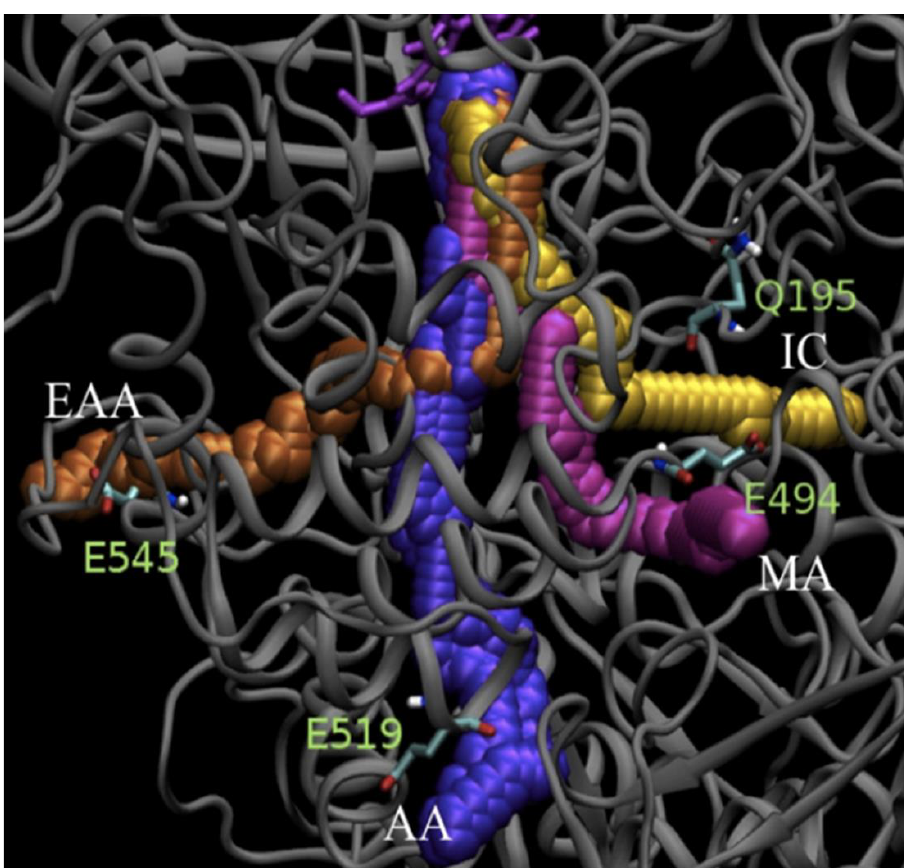
Figure 5. Permeability of accesses and channels in CAT-1. Access to the gate and the active site was determined with the CAVER program. The starting point was at the Fe of the heme. Traces define the main access and channel (MA) (pink), the auxiliary access (AA) (purple), the interconnecting channel (IC) (yellow) and the entrance to the auxiliary access (EAA) (orange). All these traces converge at the gate. Accesses are identified by the following amino acid residues: E494 in MA, E519 in AA, Q195 for IC, E545 for EAA. The heme is depicted in magenta. Reprinted with permission from ref. [43] 2010, Elsevier.